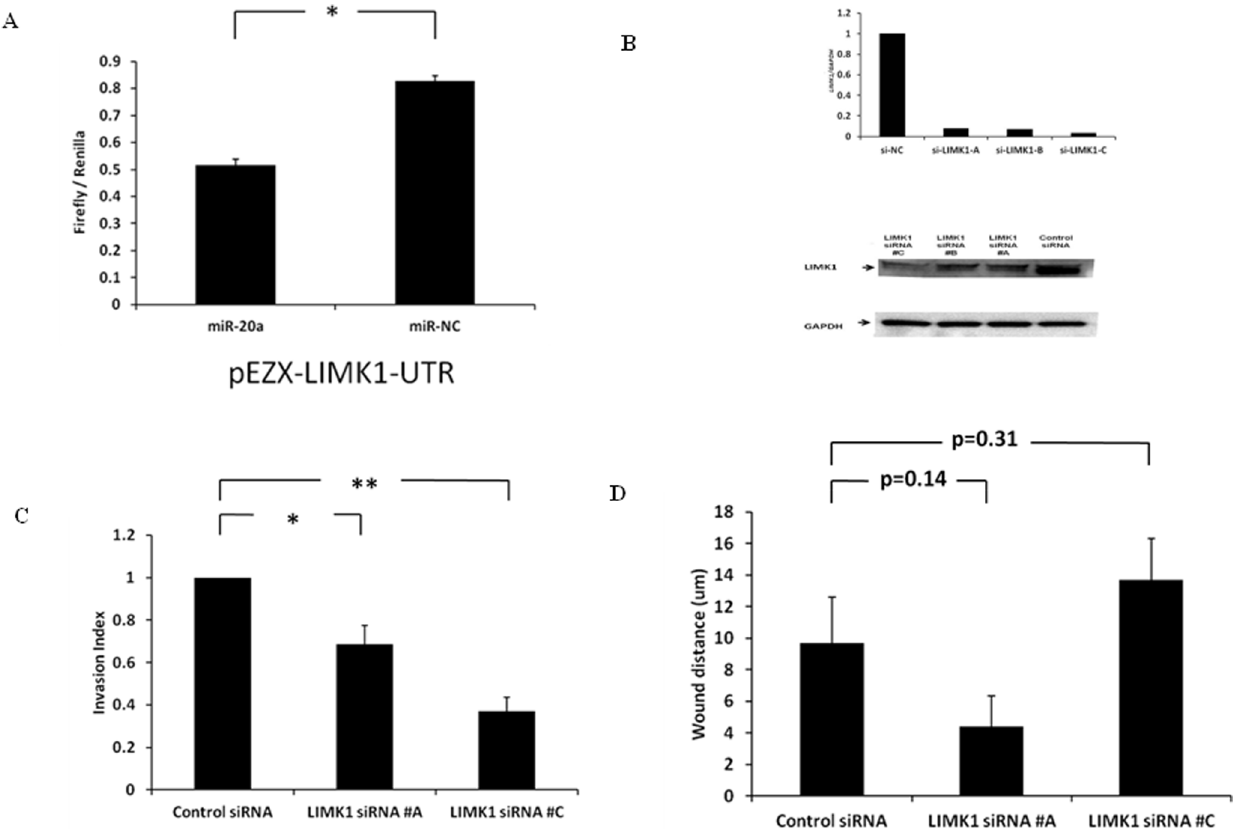
Figure 6. MiR-20a targets LIMK1 and LIMK1 regulates cellular invasion. ( A ) Luciferase activity of pEZX-LIMK1-UTR in FTC-133 cells when co- transfected with miR-20a or miR-NC. All luciferase measurements were made in triplicates and readings were performed at 24 hours post- transfection. Error bars represent standard error of mean (* indicates p , 0.05). ( B ) LIMK1 siRNA knockdown in FTC-133 thyroid cancer cell line. LIMK1 mRNA expression by quantitative RT-PCR (top panel). LIMK1 protein expression by Western blot (bottom panel). Data shown is for 72 hours after siRNA transfection. ( C ) Cellular invasion with LIMK1 knockdown. Transfection of LIMK1 siRNAs inhibited FTC-133 thyroid cancer cells invasion. The Y axis represents the invasion index of the thyroid cancer cells. Data shown is for 72 hours after siRNA transfection. Error bars represent standard error of mean (* indicates p , 0.05; ** indicates p , 0.01). ( D ) Transfection of LIMK1 siRNAs has no effect on the migration of FTC-133 thyroid cancer cells. The Y axis represents the wound distance. Data shown is for 72 hours after siRNA transfection. Error bars represent standard error of